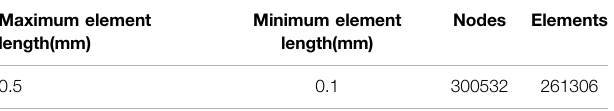
TABLE 2 | Mesh parameters Maximum element length(mm)